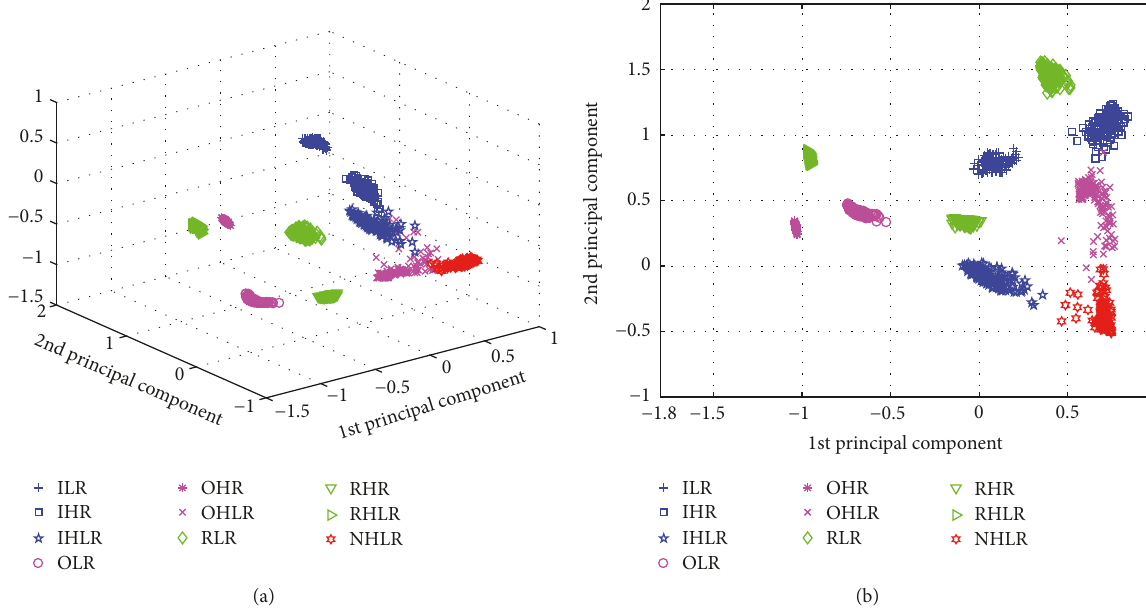
categories are farther in three-dimensional space. The results show that standard SAE can extract effective features from Fourier coefficients and make good diagnosis result just as [10]. But the proposed method can extract better feature than SAE due to the fact that the kernel function maps the input data to a high eigenspace, which helps to get precise state